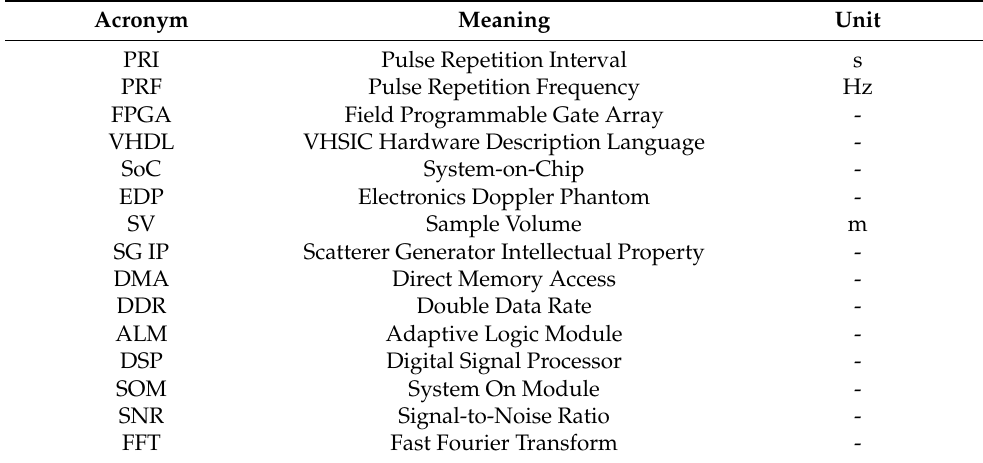
Table A1. Nomenclature employed in the